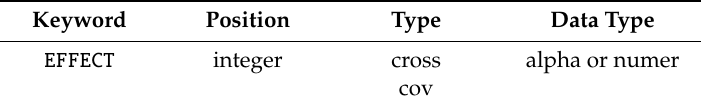
Table A2. Declaration of fixed e ff ects in